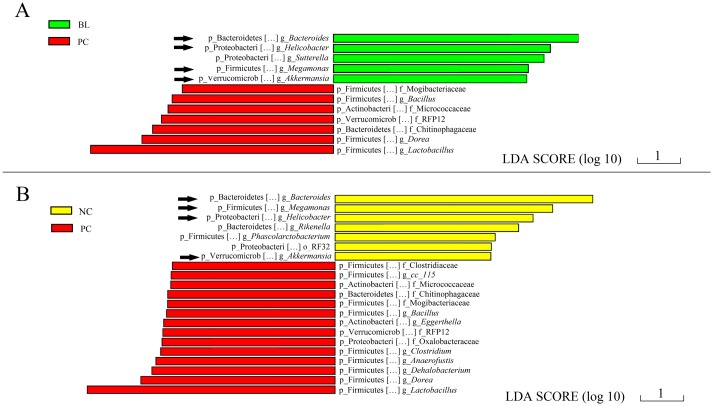
Taxa that were significantly differentially represented in the ceca of chickens with C. perfringens, Eimeria challenge and fishmeal supplementation compared with the negative control and Bacillus licheniformis treatment groups.(A) Differentially overrepresented taxa in group PC versus group BL. (B) Differentially overrepresented taxa in group PC versus group NC. Phylum and genus level names are shown. Sequences that could not be classified at the genus level were named according to the next highest level. NC, negative control; PC, treated with C. perfringens, coccidia, and fishmeal; BL, pre-treated with B. licheniformis then treated with C. perfringens, coccidia, and fishmeal.